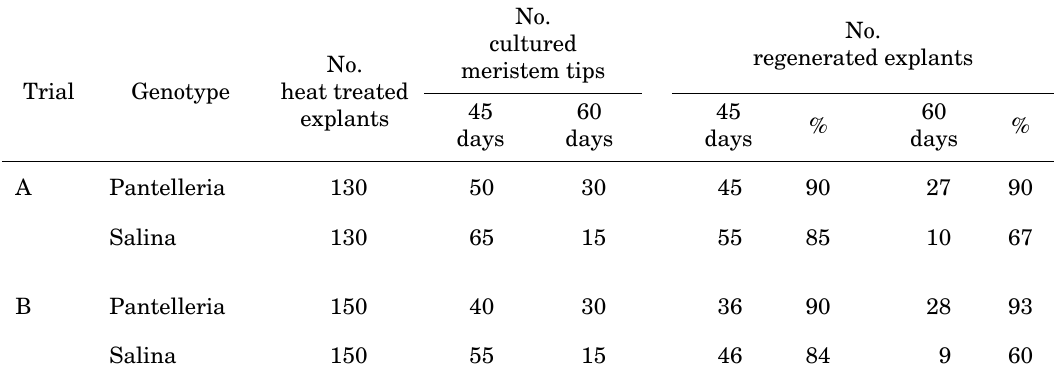
Table 2. CapLV elimination in regenerated caper explants as determined by RT- PCR.